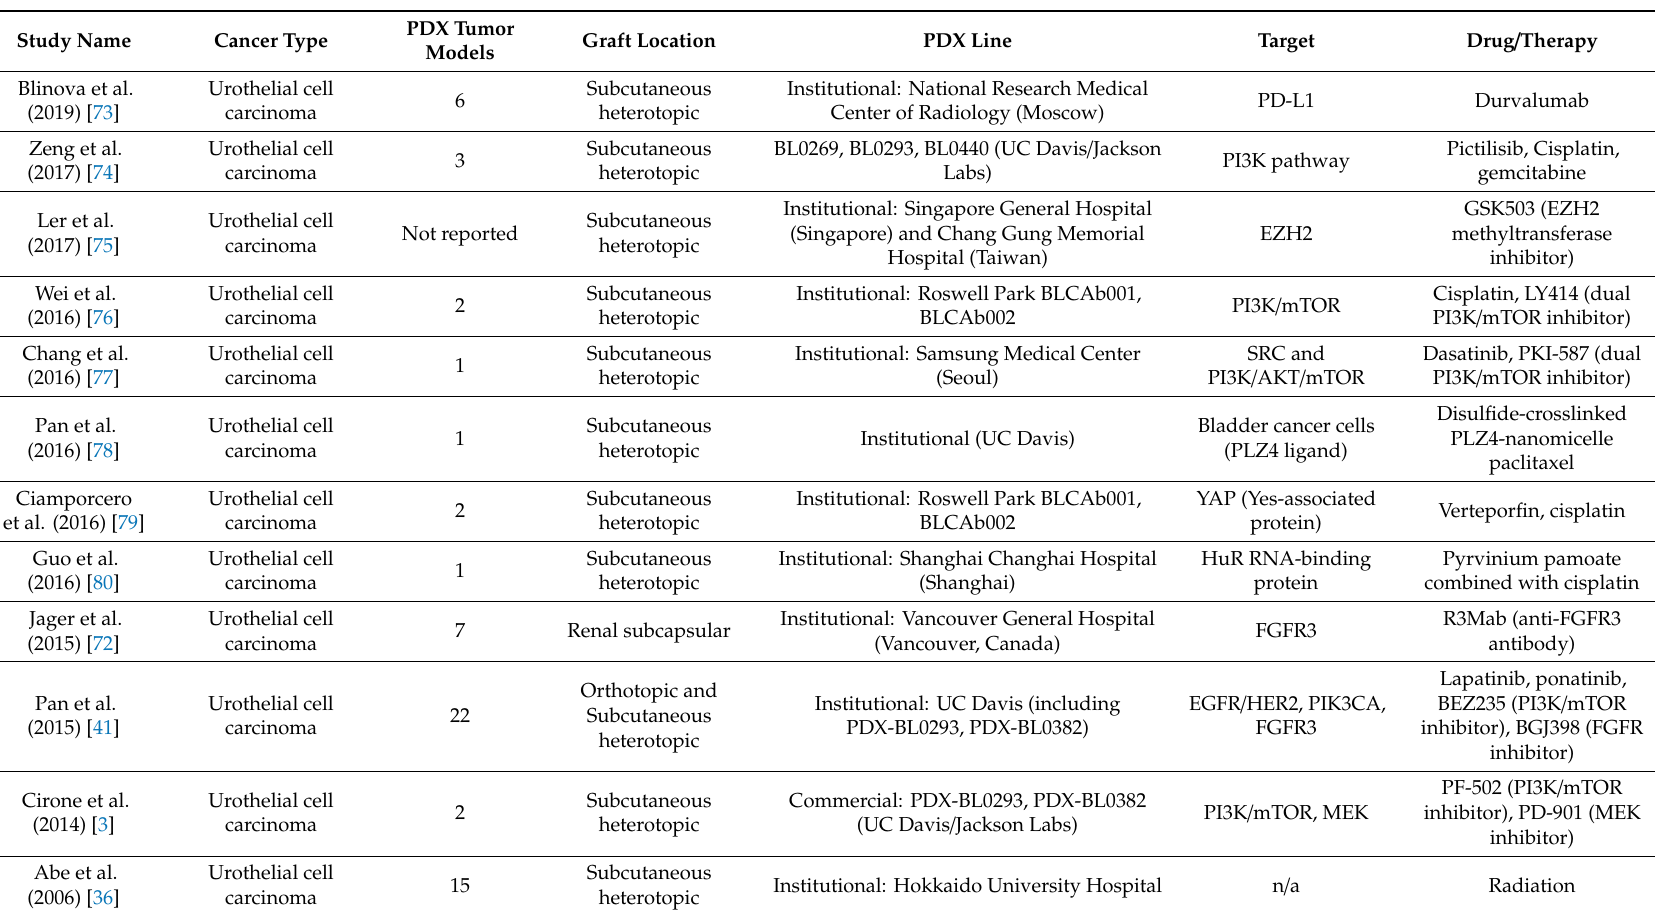
Table 2. Published studies of targeted anti-neoplastic treatments utilizing novel patient-derived tumor xenografts models in urothelial cell